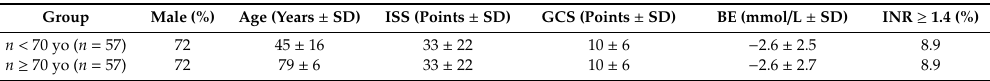
Table 2. Matching results and base characteristics of the matched couples.